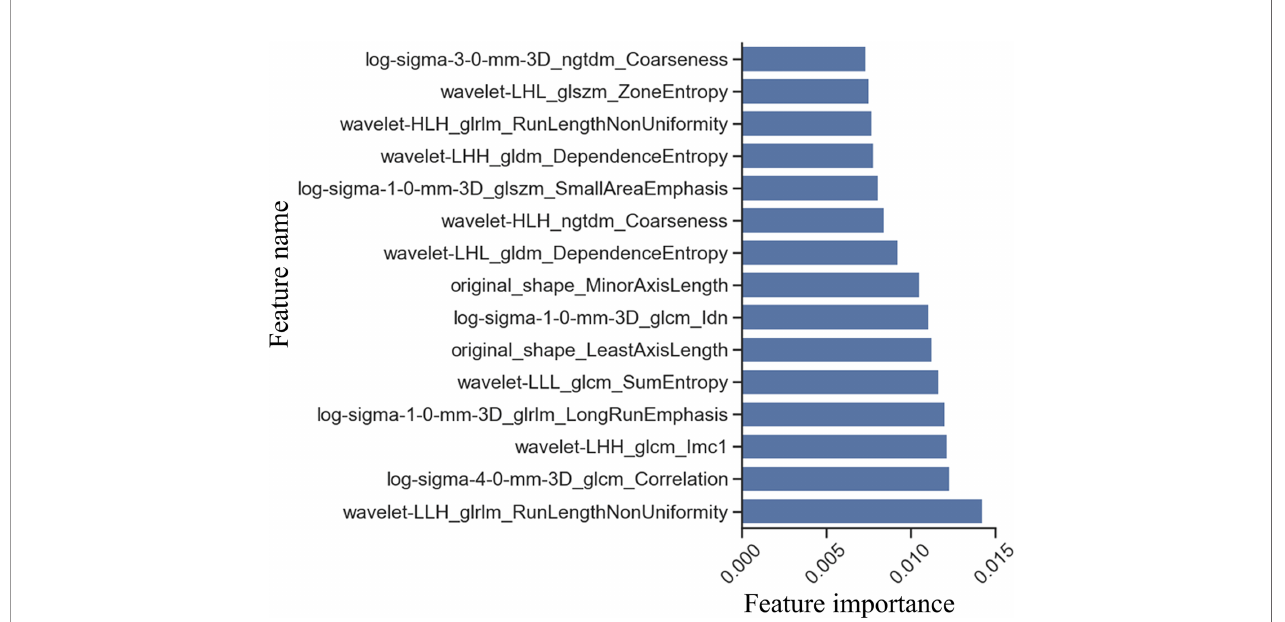
FIGURE 2 | Feature selection by Extra-trees. Feature importance was obtained by averaging the results of multiple decision tree in Extra-trees. The larger the feature score, the more important is the